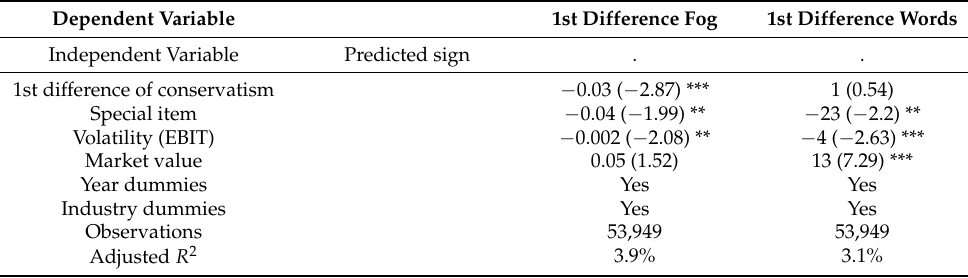
Table 3. The determinants of changes in Fog and number of words. Dependent Variable